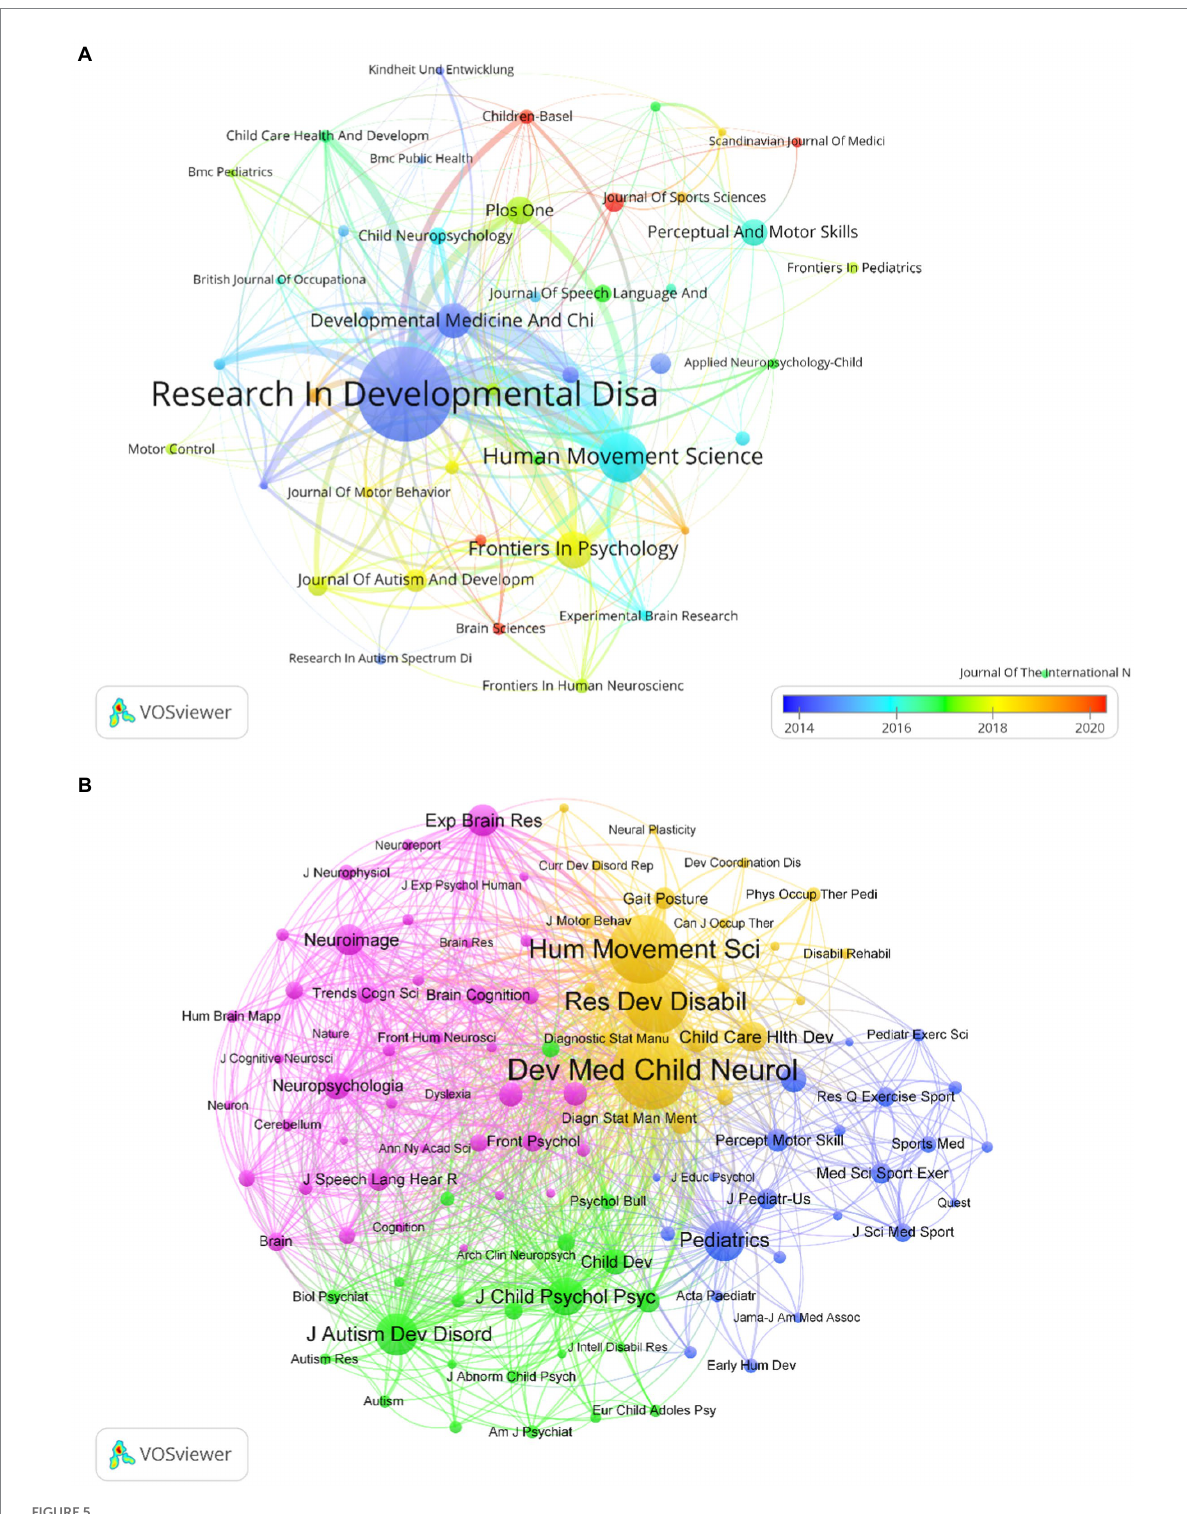
FIGURE 5 (A) Average annual publication year map of journals based on VOSviewer; (B) Co-citation network visualization map of co-cited journals based on VOSviewer.